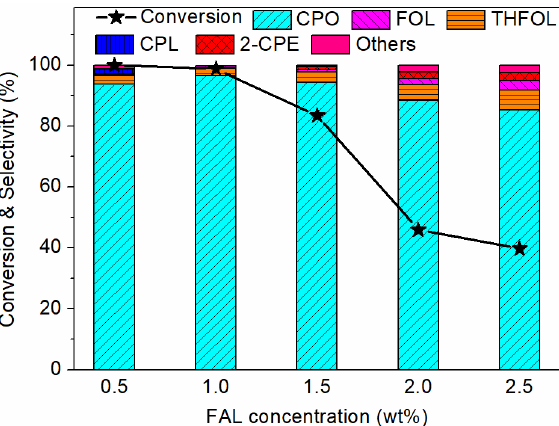
Figure 7. Effect of FAL concentration on conversion and product selectivity in hydrogenative ring- rearrangement of FAL over Pd/UiO-66-NO 2 - 7 . Reaction conditions: catalyst (5.0 mg), H 2 O (9.9 g), 150 °C, 1.0 MPa H 2 pressure, 5 h.